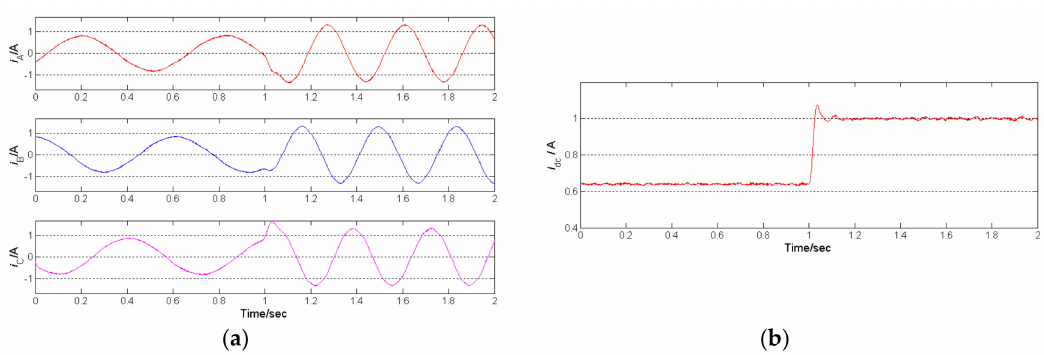
Figure 22. Current control results of proposed method. ( a ) Phase currents; ( b ) DC-link